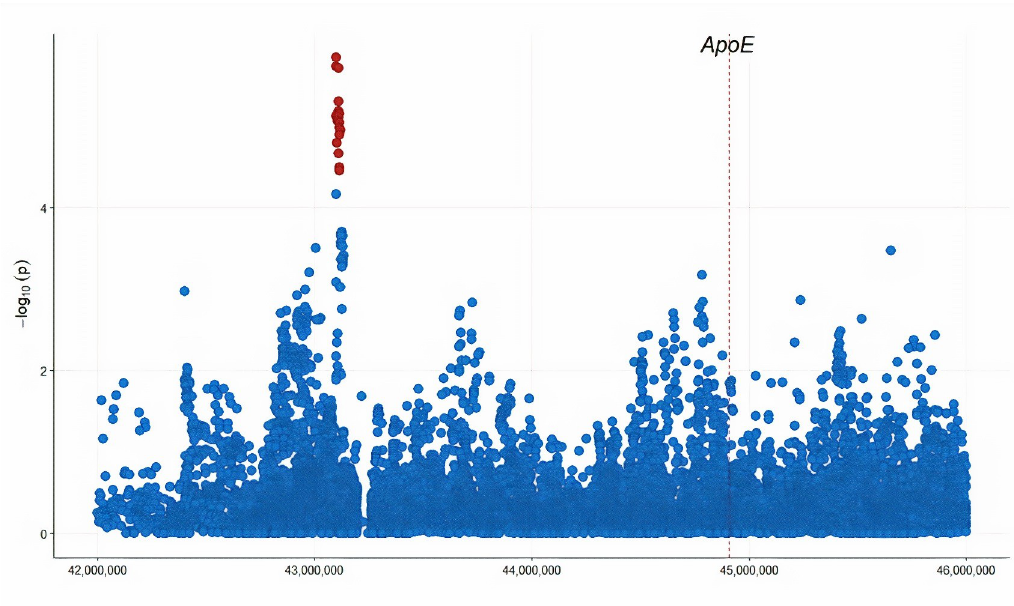
Fig 2. The regional plot of logistic regression analysis across the ApoE region for the interaction term. Genomic coordinates are displayed along the X-axis. Negative logarithm of the association p-value for the interaction term is displayed on the Y-axis, with the red color representing markers that have FDR adjusted p-value <